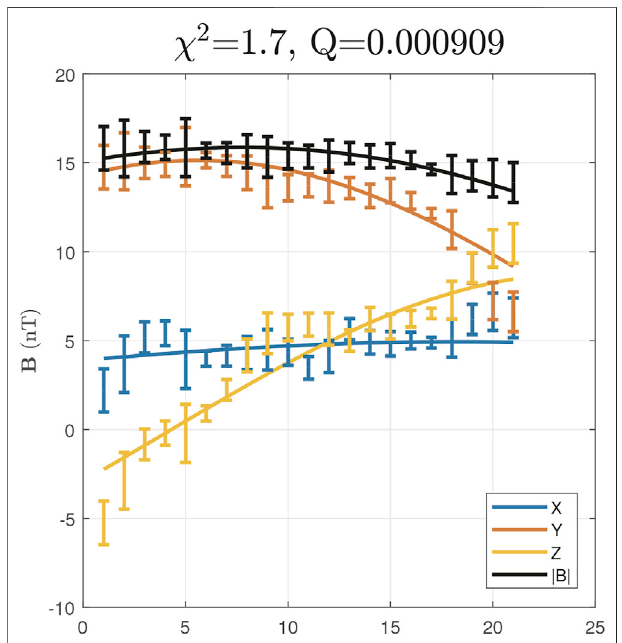
FIGURE6 | The optimal fi tting result tothe Freidberg solutionfor the MC interval marked in Figure 1A . The Wind spacecraft measurements of the magnetic fi eld with uncertainty estimates are shown as error bars, while the correspondinganalyticsolutionisgivenbysolidcurves(seelegend). The horizontal axis is the integral index of the data